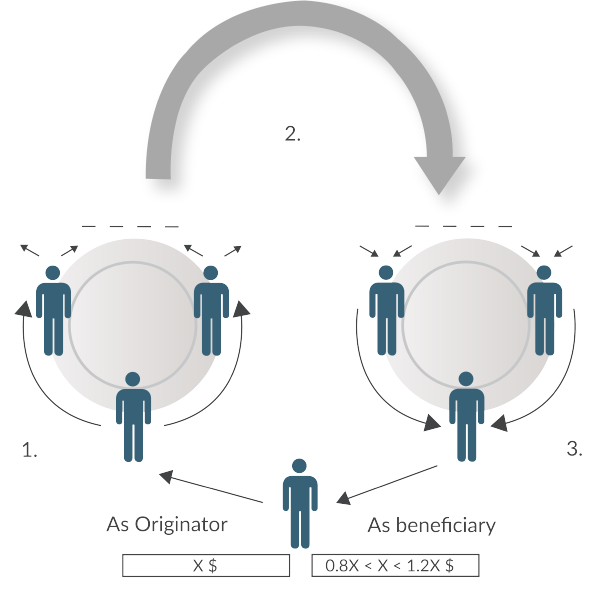
Figure 4. Rapid mvmt funds